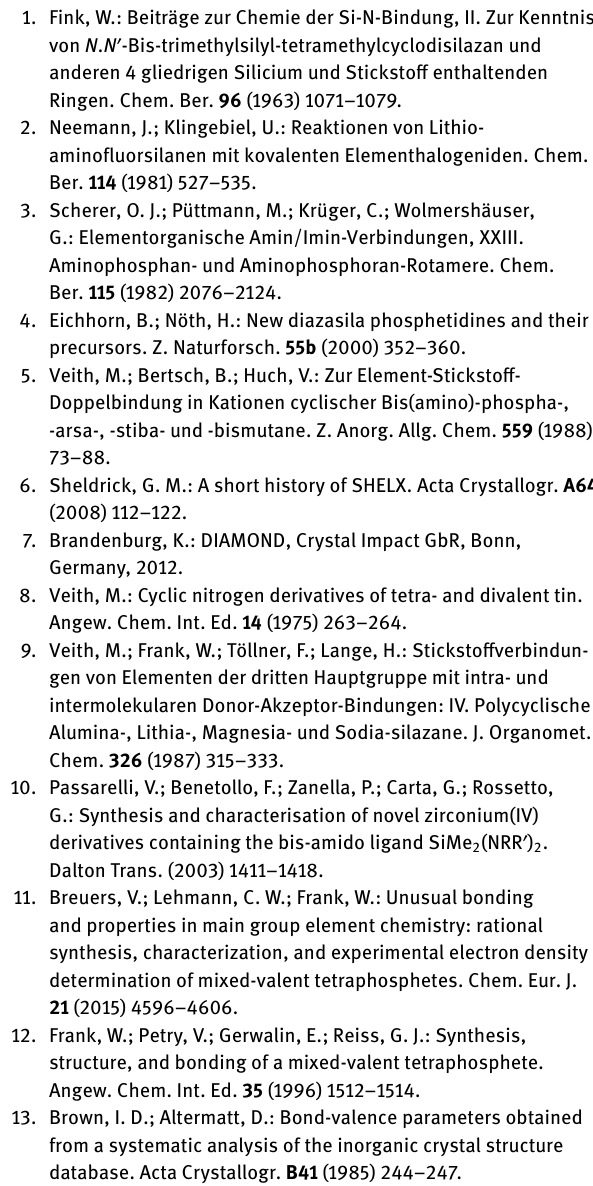
packings of the title compound and of the higher